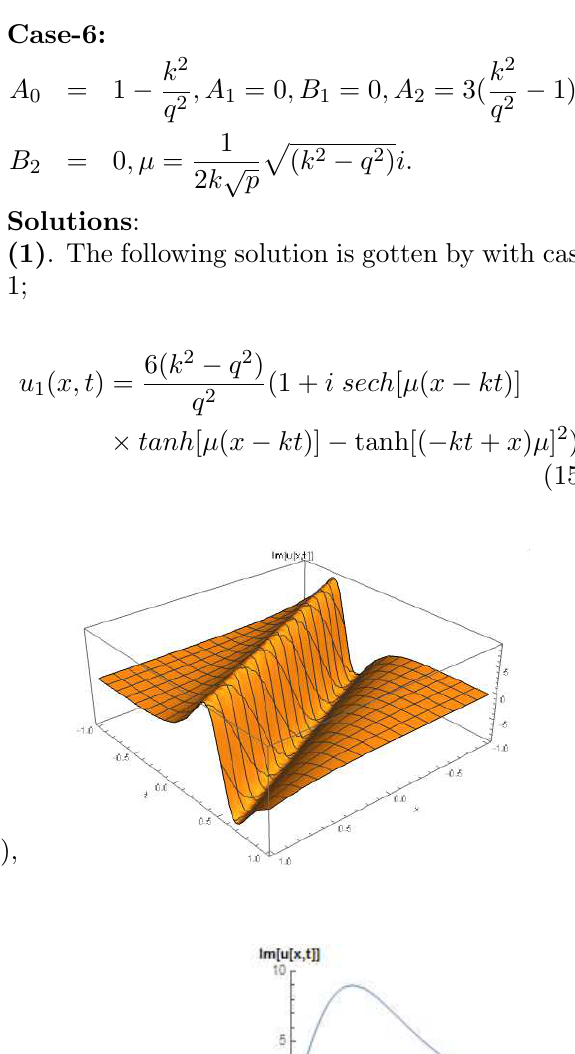
Figure 1. The 3D shape for the imaginary part of Eq. (15) with the values k = 2, c 0 = 1, µ = 3, x < 3, 5 < t < 5 and t = 0 for the − graphic of